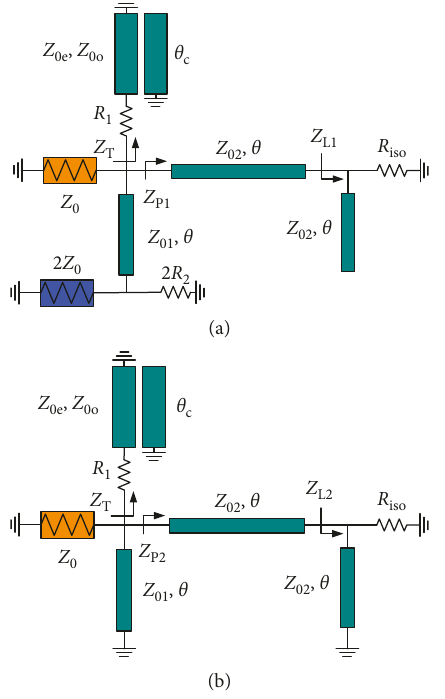
Figure 2: Equivalent circuits of the proposed NGD Gysel power divider. (a) Even-mode. (b)